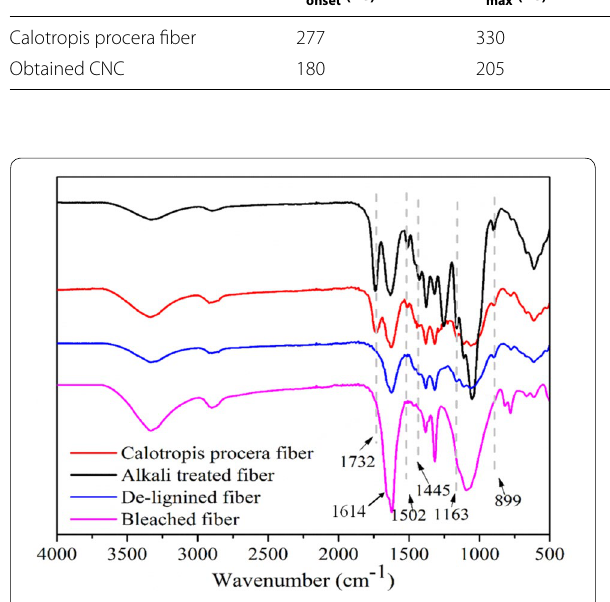
Fig. 3 FTIR spectrum of the Calotropis procera fiber, alkali treated Calotropis procera fiber, delignined Calotropis procera fiber and bleached Calotropis procera fiber